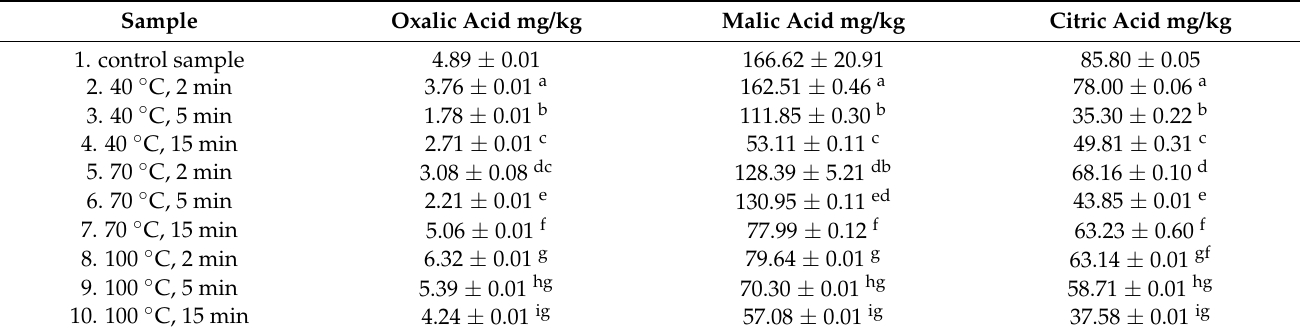
Table 4. Effect of sample heat treatment at 40, 70, 100 ◦ C on the content of organic acids by the HPLC method.